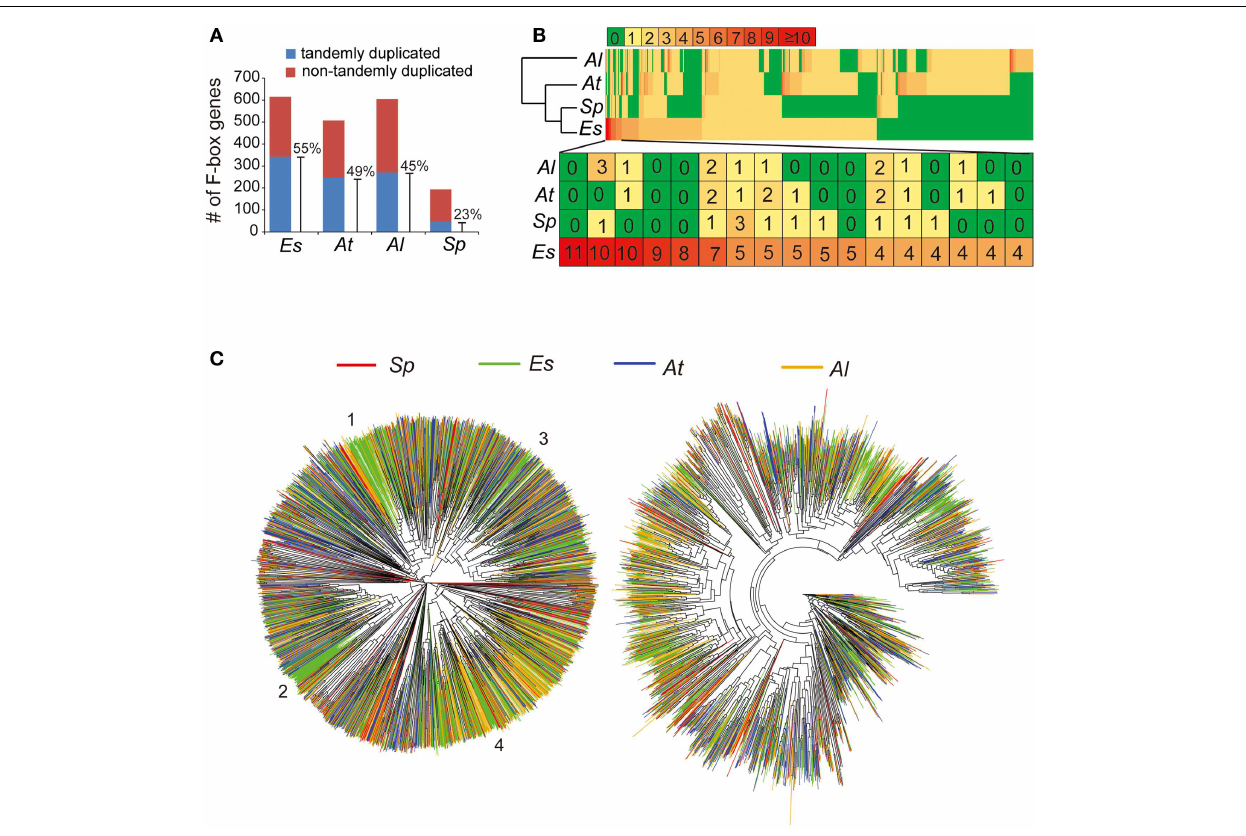
the total of ∼ 1900 F-box genes identified in the four species.The tree on the right was built based on the ∼ 60-aa F-box domain. Four E. salsugineum specific F-box clades were numbered by 1–4.The tree on the left was built based on the alignment of full CDS sequences of F-box genes in the four